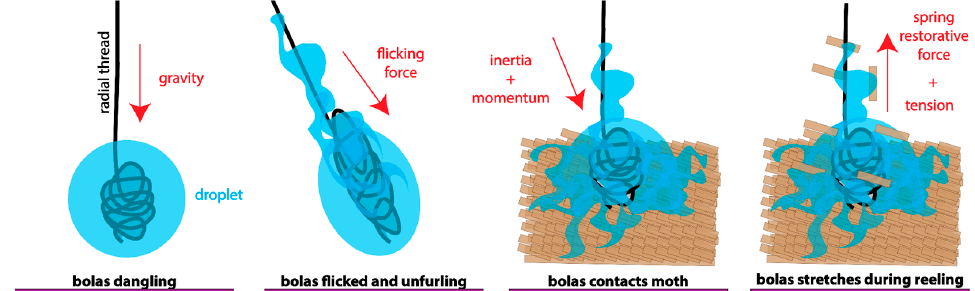
Figure 5. Speculative model of a bolas interacting with the scaled surface of the moth. The bolas has a viscous glue droplet containing a windlass of coiled silk. The flicking force of the spider stretches the glue droplet, with the internal silk of the windlass allowing it to stretch, spring-like, and to retain the liquid phase. If the droplet fails to hit the moth, the glue droplet returns elastically to its original spherical form. If the droplet hits the moth, the collision with the substrate initially dislodges scales. The tension on the thread, caused by the escaping moth, begins to unravel the windlass as it is pulled through the glue, causing the glue to spread within the matrix of the scales. The hydrophobic nature of the scales causes them to be pulled to the surface and pulled upward, cleaning the area and allowing the remaining glue to connect with the underlying cuticle. As the tethered moth struggles to escape, angular momentum is generated, leading to further contact between the glue droplet and moth substrate. The interactions of the bolas, both liquid phase and windlass, with the scales of the moth, are speculative, based on previous work of glue spreading in the previously analyzed moth-specialist, C. akirai .